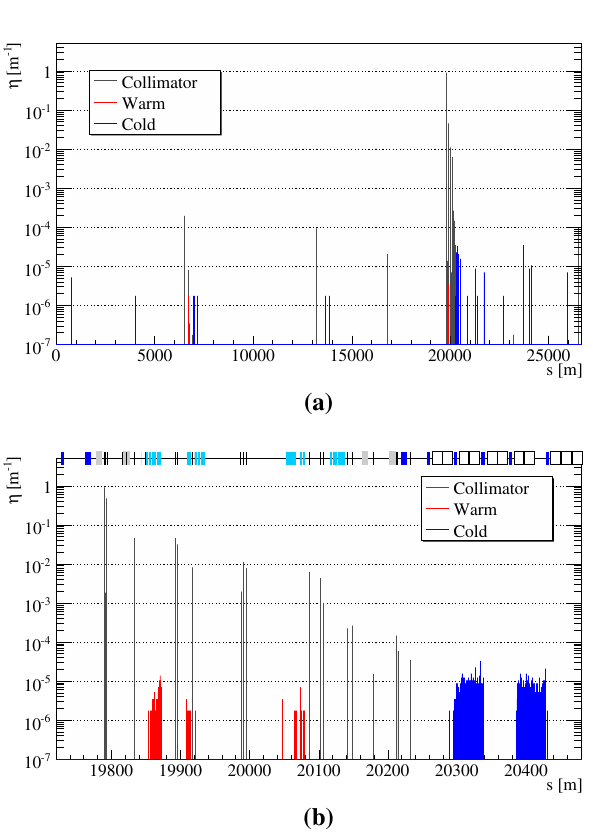
Fig. 4 Simulated beam-loss pattern at End of Squeeze, with 6.5 TeV/c beams in 2018 and operational settings. The whole LHC ( a ), zoom